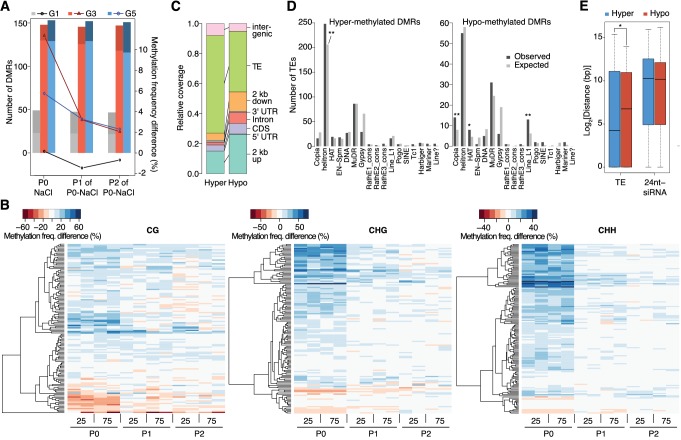
Dynamics of methylation frequency changes in DMRs.(A) DMRs that are hypo- (darker colours) or hyper-methylated (lighter colours) in stress-treated P0 and their P1 and P2 progeny compared to the average of all control samples. Methylation states were determined by subtracting the methylation frequency of a DMR in the respective sample from the combined controls (P0, P1 and P2) of that generation (G1, G3, or G5); positive differences were considered as hyper-, negative differences as hypo-methylation events. Line plots indicate the absolute net methylation frequency change (in% ) across all DMRs. (B) One-directional clustering of DMRs in G3 by methylation frequency difference, separated by sequence context. Differences for each DMR were calculated by subtracting the methylation frequency of the DMR in a sample from the average in the combined P0, P1 and P2 control samples (see also Figure 1a). Blue colour indicates hyper-, red colour indicates hypomethylation. 25, 25 mM NaCl; 75, 75 mM NaCl; C, control. (C) Annotation of DMRs. (D) Classes of TEs next to DMRs. (E) Distance of DMRs to the nearest transposable element (TE) or 24 nt-siRNA locus (Fahlgren et al., 2010) (unpaired Student’s t-test; *p<0.05). Horizontal bar corresponds to median, whiskers indicate entire 95th percentile; outliers are not shown.